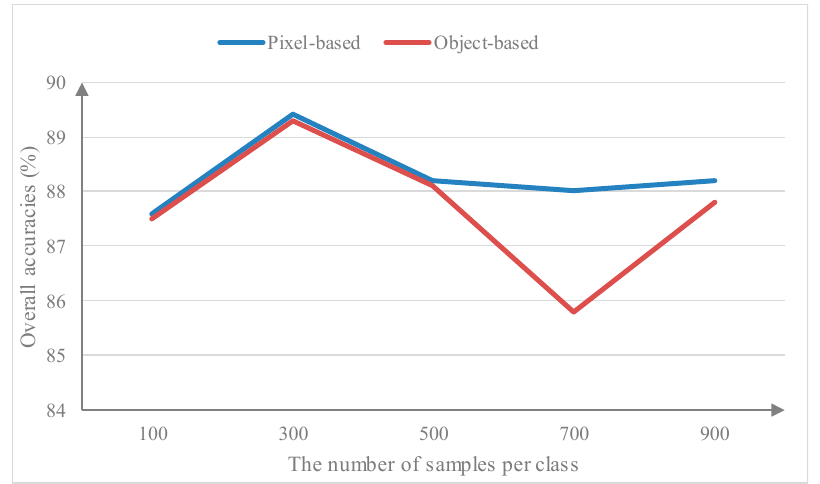
Figure 9. Accuracies with different numbers of training samples.